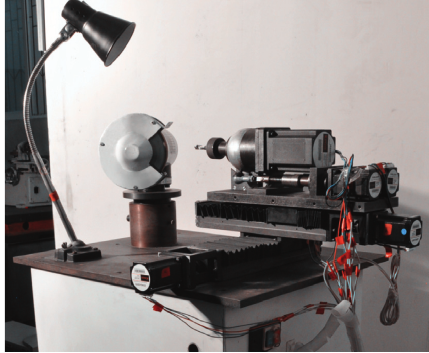
Figure 2: Three-parallel CNC grinding machine.